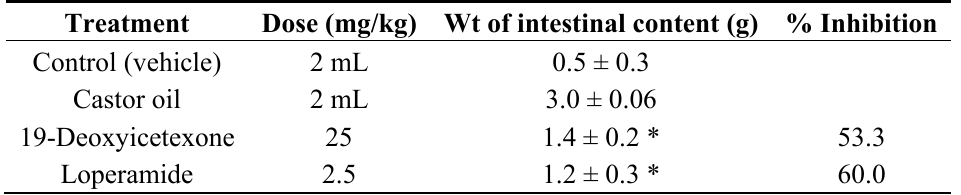
Table 4. Effect of 19-deoxyicetexone on castor oil induced intestinal fluid